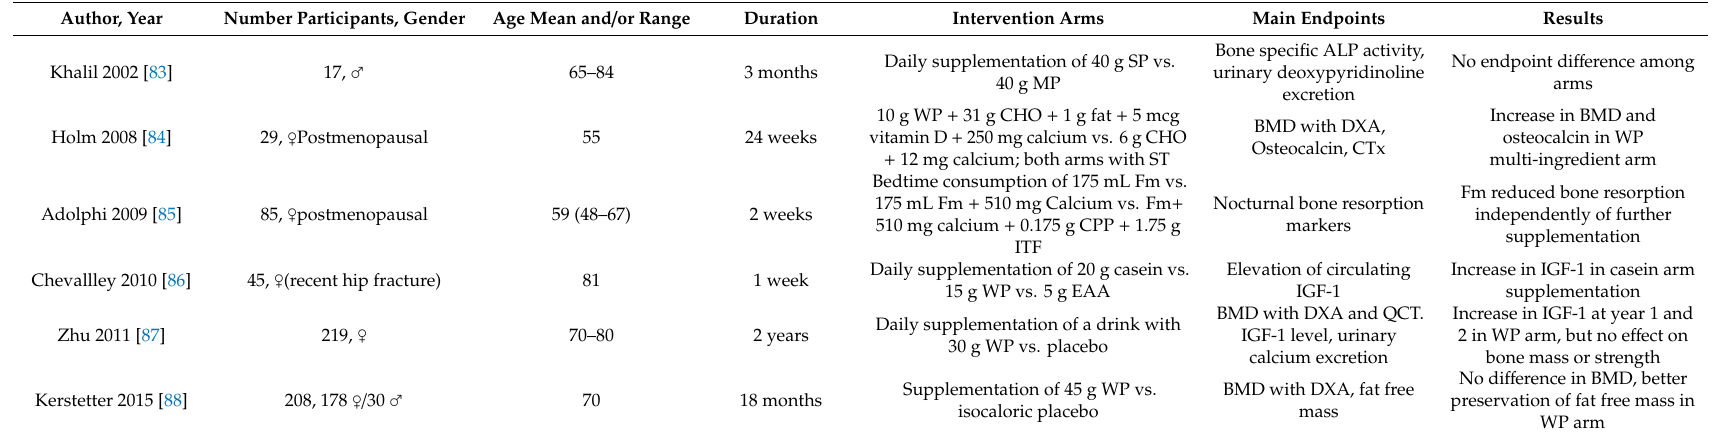
Table 3. RCTs investigating the e ff ect of daily supplementation of di ff erent combination of protein sources, calcium and fructans on several bone related